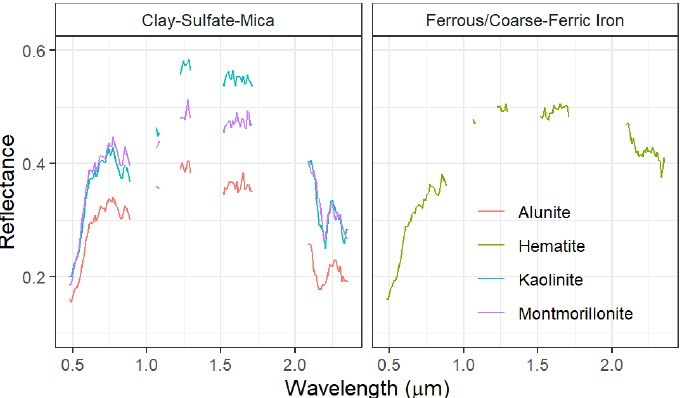
Figure 4. Hyperion spectra of alunite, kaolinite, montmorillonite, and hematite found at Cerro Carcanal and vicinity. The identification of minerals is the overall result of SAM and SFF methods in ENVI Spectral Analyst tool. The entire 0.48–2.5 µ m wavelength range was used for hematite spectrum identification, and both 0.48–2.5 and 2.0–2.5 µ m wavelength ranges were used for alu- nite/kaolinite/montmorillonite spectrum